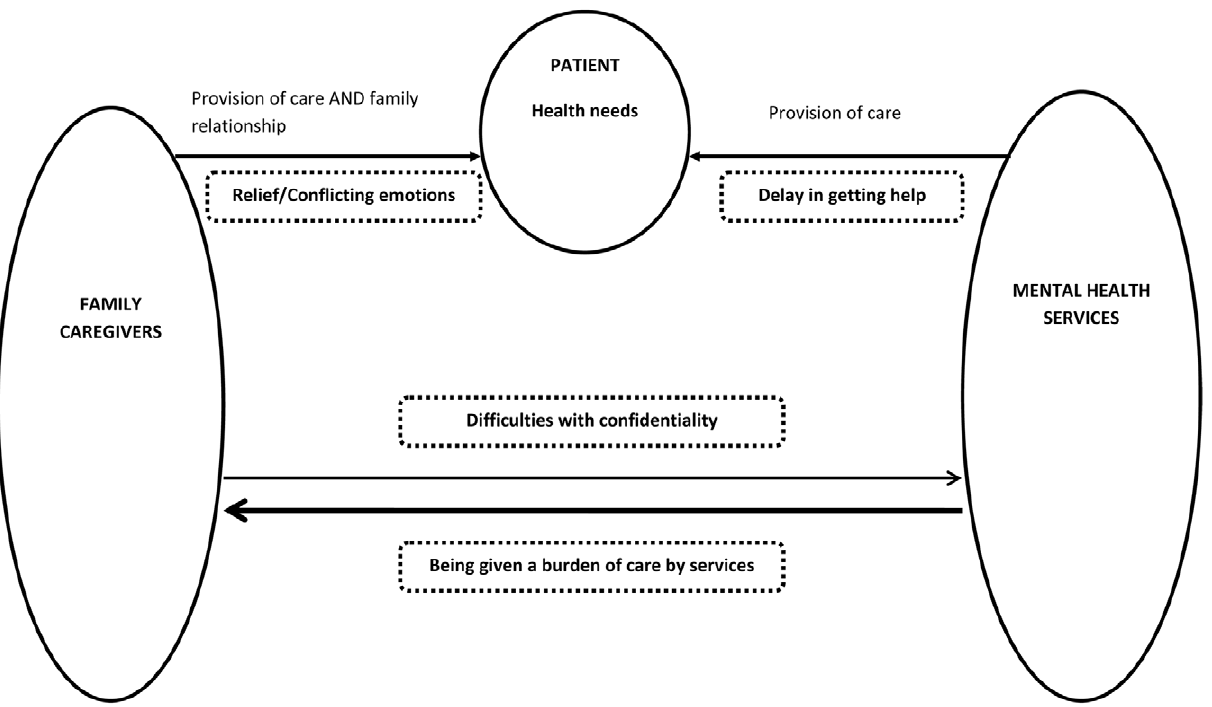
Figure 1. Schematic representation of family caregivers’ experiences of involuntary admission of their relative.